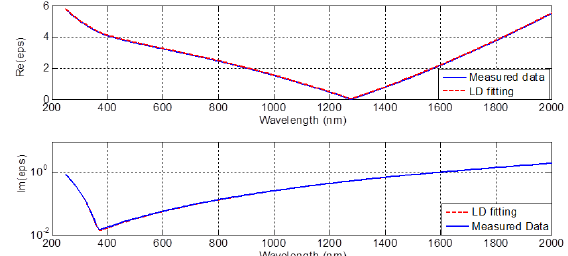
Figure 2. LD fitting curves for the real and the imaginary parts of the ITO permittivity using experimental data in [3].